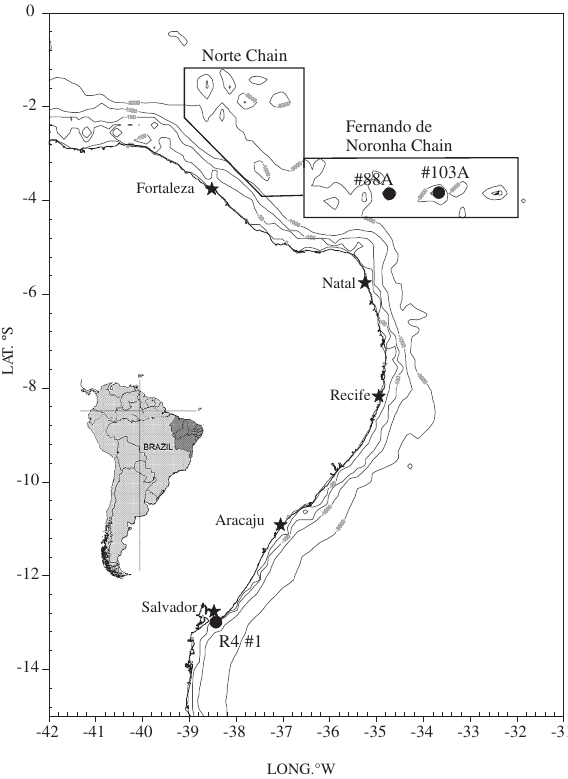
Fig . 1. – Map showing stations of the reVizee Benthos sCore/ northeast and Central collections along the continental shelf of Bra- zil. stars represent the capitals of the Brazilian